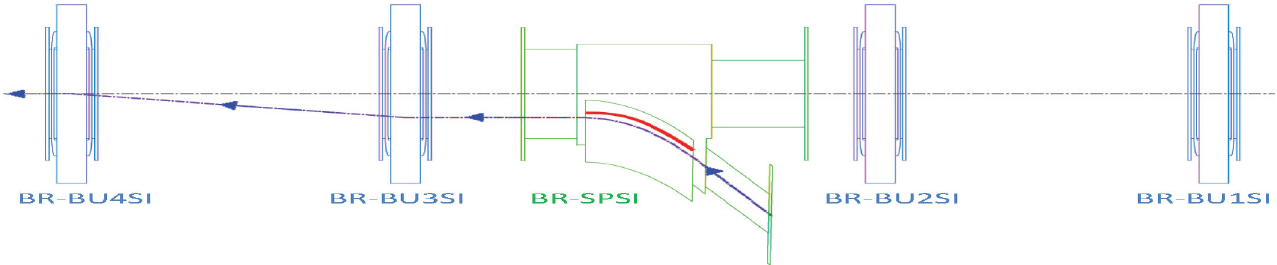
FIG. 6. Schematic of the booster injection straight showing the injection of the first bunch train. The blue magnets are the injection kickers, the green magnet is the septum, the red line denotes the septum